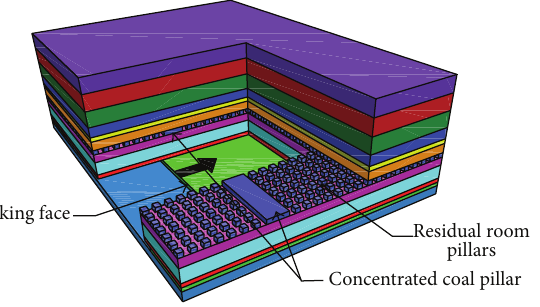
Figure 1: Three-dimensional structure of 31201 working face in Shigetai mine.